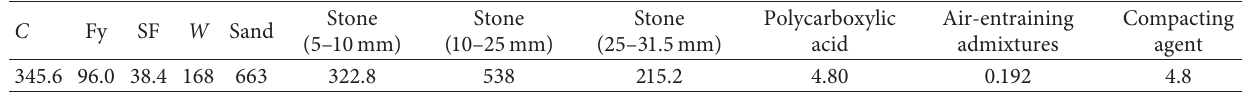
Table 3: The initial mix proportion of C40 pavement concrete (kg/m 3 ).